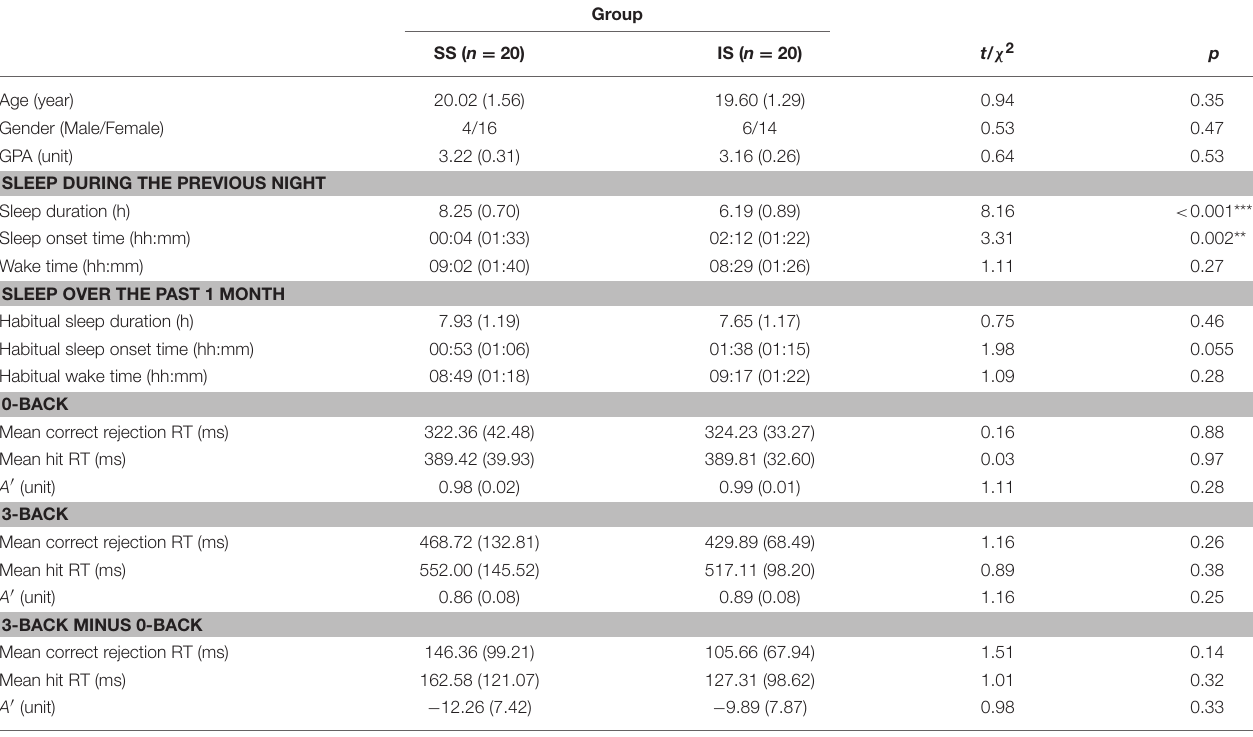
TABLE 1 | Demographic Characteristics and n -Back Task Performance of the Sufficient Sleep (SS; n = 20) and Insufficient Sleep (IS; n = 20) Groups.